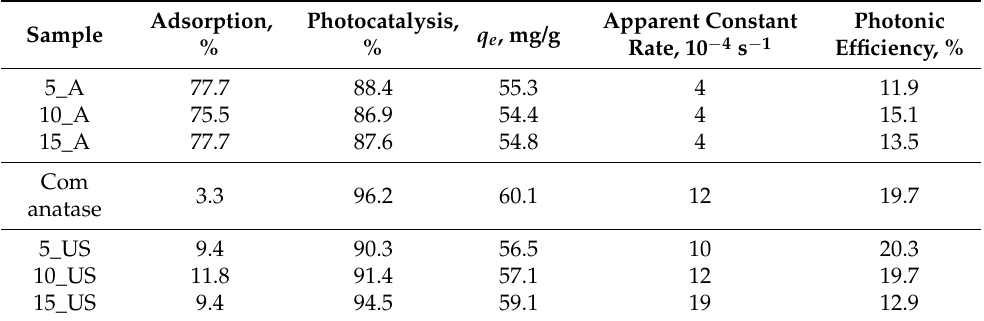
Table 4. Photocatalytic performance of the synthesized porous titania samples for MB degradation under